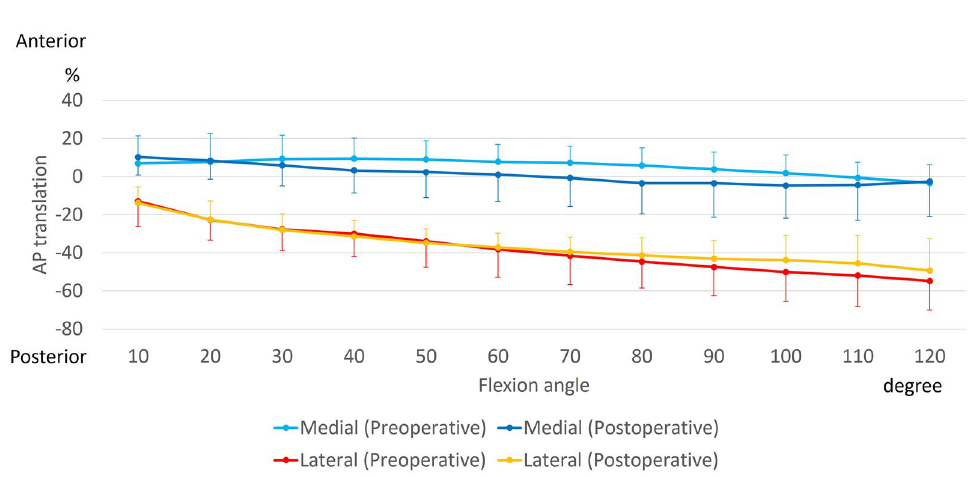
Figure 3. Anteroposterior (AP) translation of medial and lateral side of the femur during squatting. AP translation is calculated as a percentage relative to AP length of the tibia.